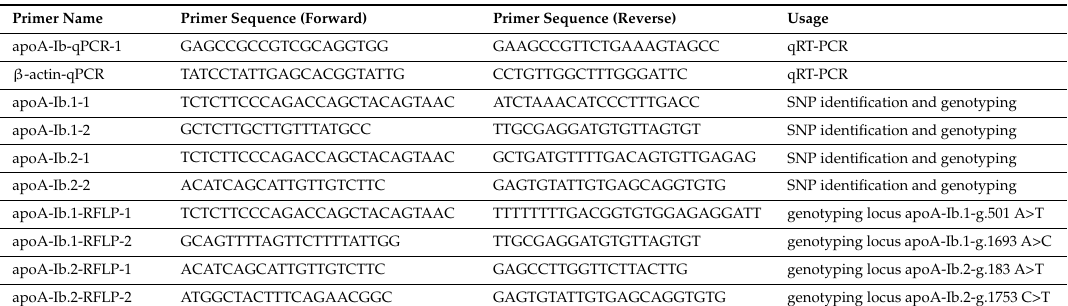
Table 3. Primers used in this